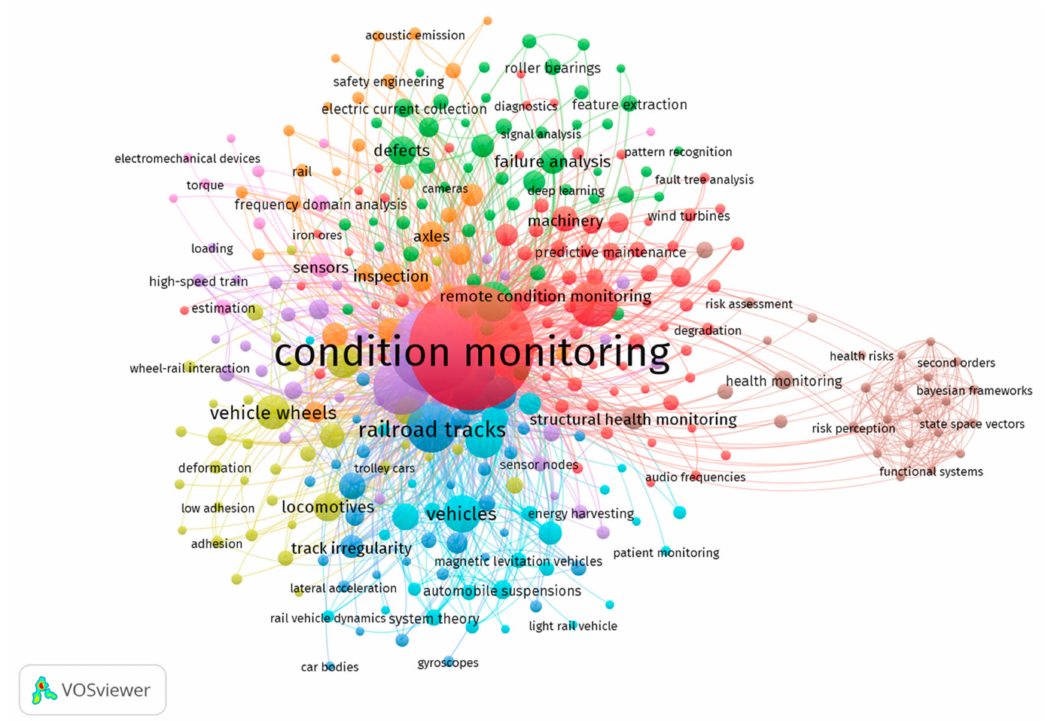
Figure 13. Complete set of keywords significant to the research gathered around the internal keywords “condition monitoring”. Source: Own study applied using VOSviewer software (version